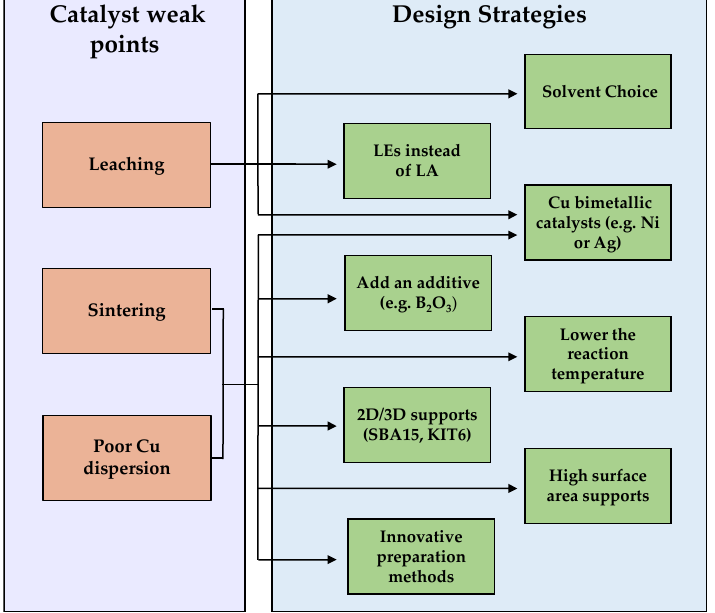
Figure 3. Main factors limiting the catalyst scale-up and the design strategies aimed at optimizing the performance.